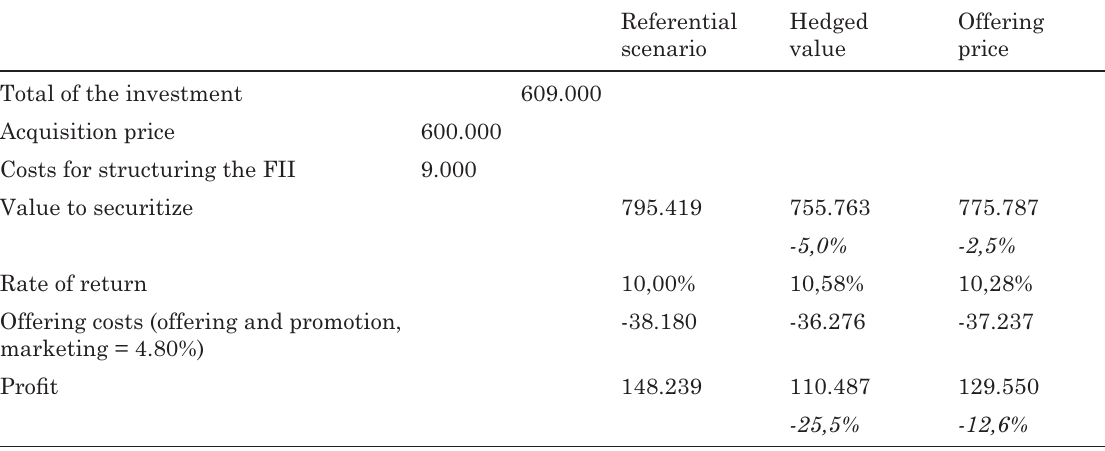
Table 4. Balance sheet – acquisition, securitization and